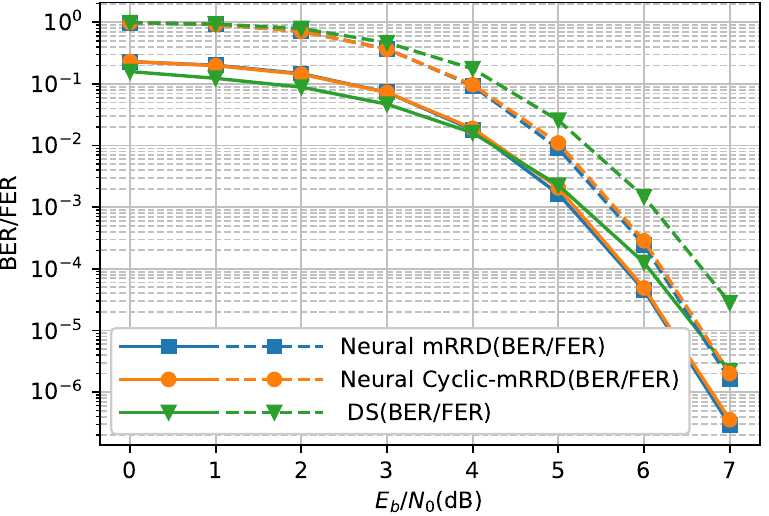
Figure 11. BER/FER performance of different decoders for the (97,49) QR